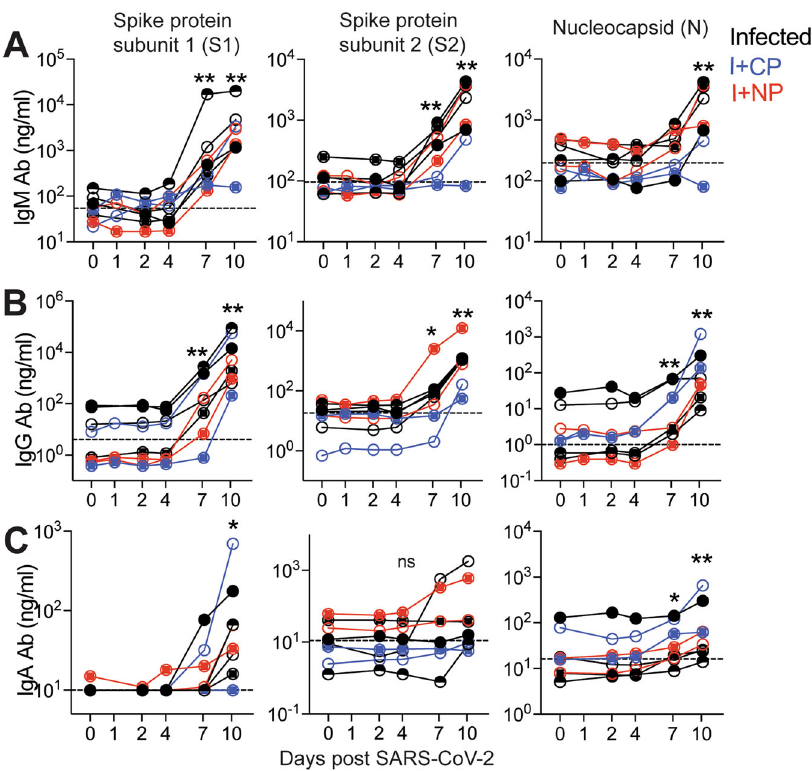
Fig. 9 Humoral responses to SARS-CoV-2 are dominated by IgG antibodies. Concentrations of A IgM, B IgG, and C IgA antibodies (Ab) speci fi c for S1, S2, and N proteins measured by BAMA or ELISA in serum. The dashed line represents the median pre-infection (day 0) concentration for all animals. Unique symbols identify animals in each of the experimental groups. (** p = 0.007, * p = 0.015 at indicated time points relative to d0 using a Wilcoxon matched- pairs signed-rank two-tailed t